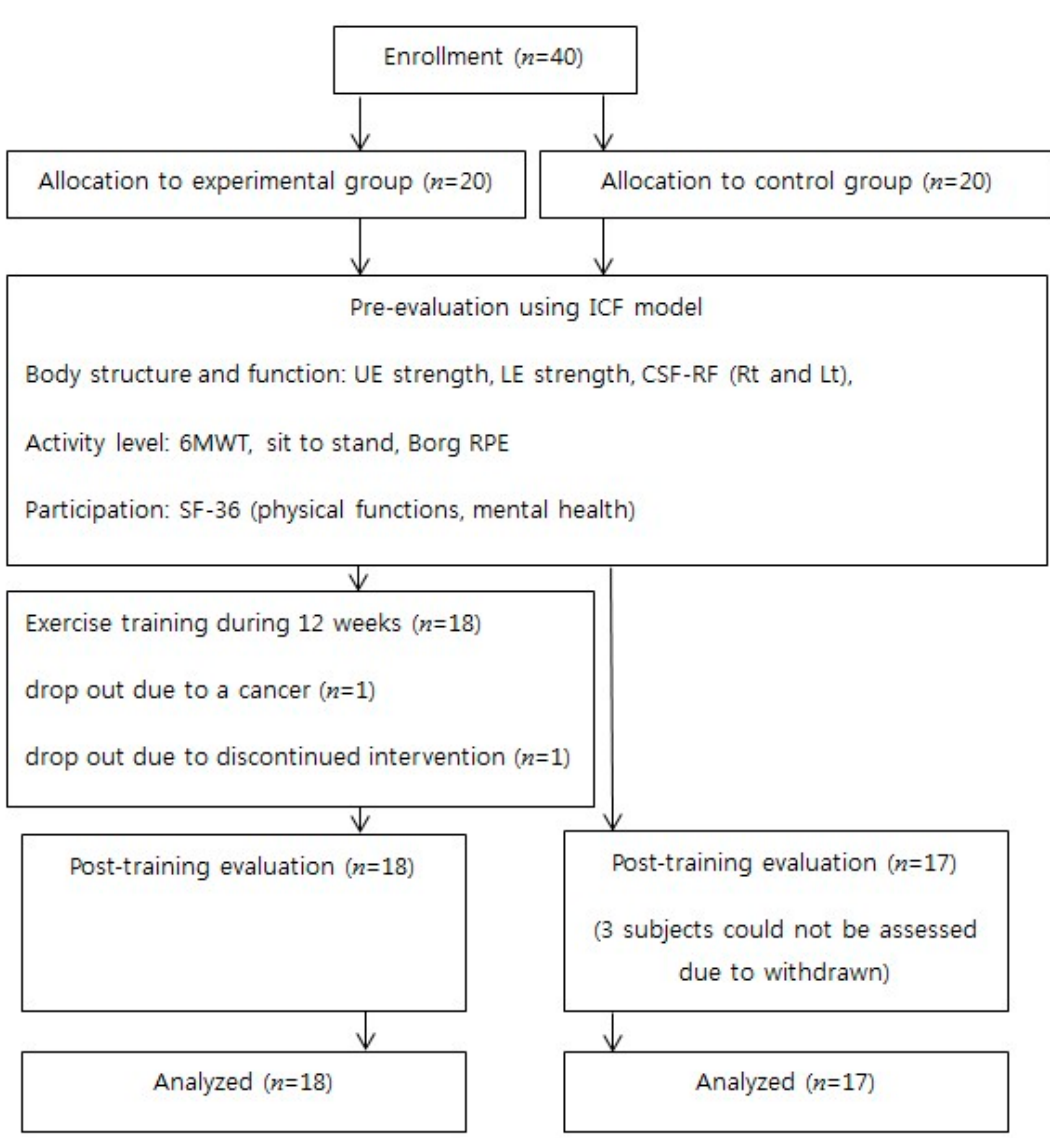
Figure 1. Subject flowchart. n , Number; ICF, International Classification of Functioning, Disability, and Health; UE, Upper Extremity; LE, Lower Extremity; CSA-RF, The cross-sectional area of the rectus femoris; 6mwt, 6-min walk test; RPE, Rating of Perceived Exertion.